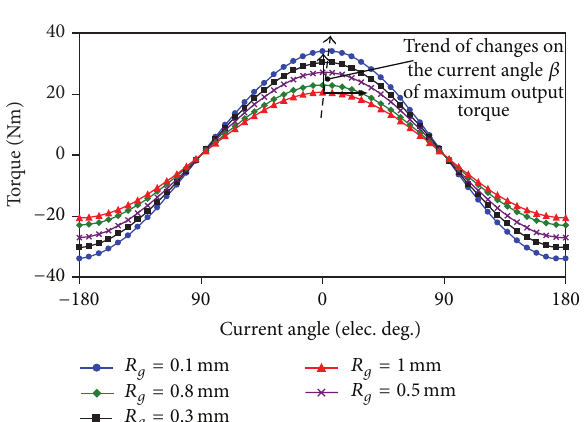
Figure 6: Variations of torque characteristic with air-gap length 𝑅 𝑔 .